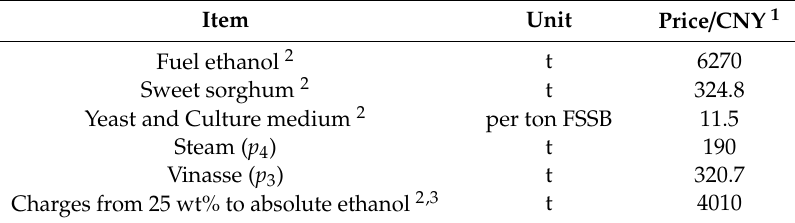
Table 3. The price of raw materials, utilities, and products.